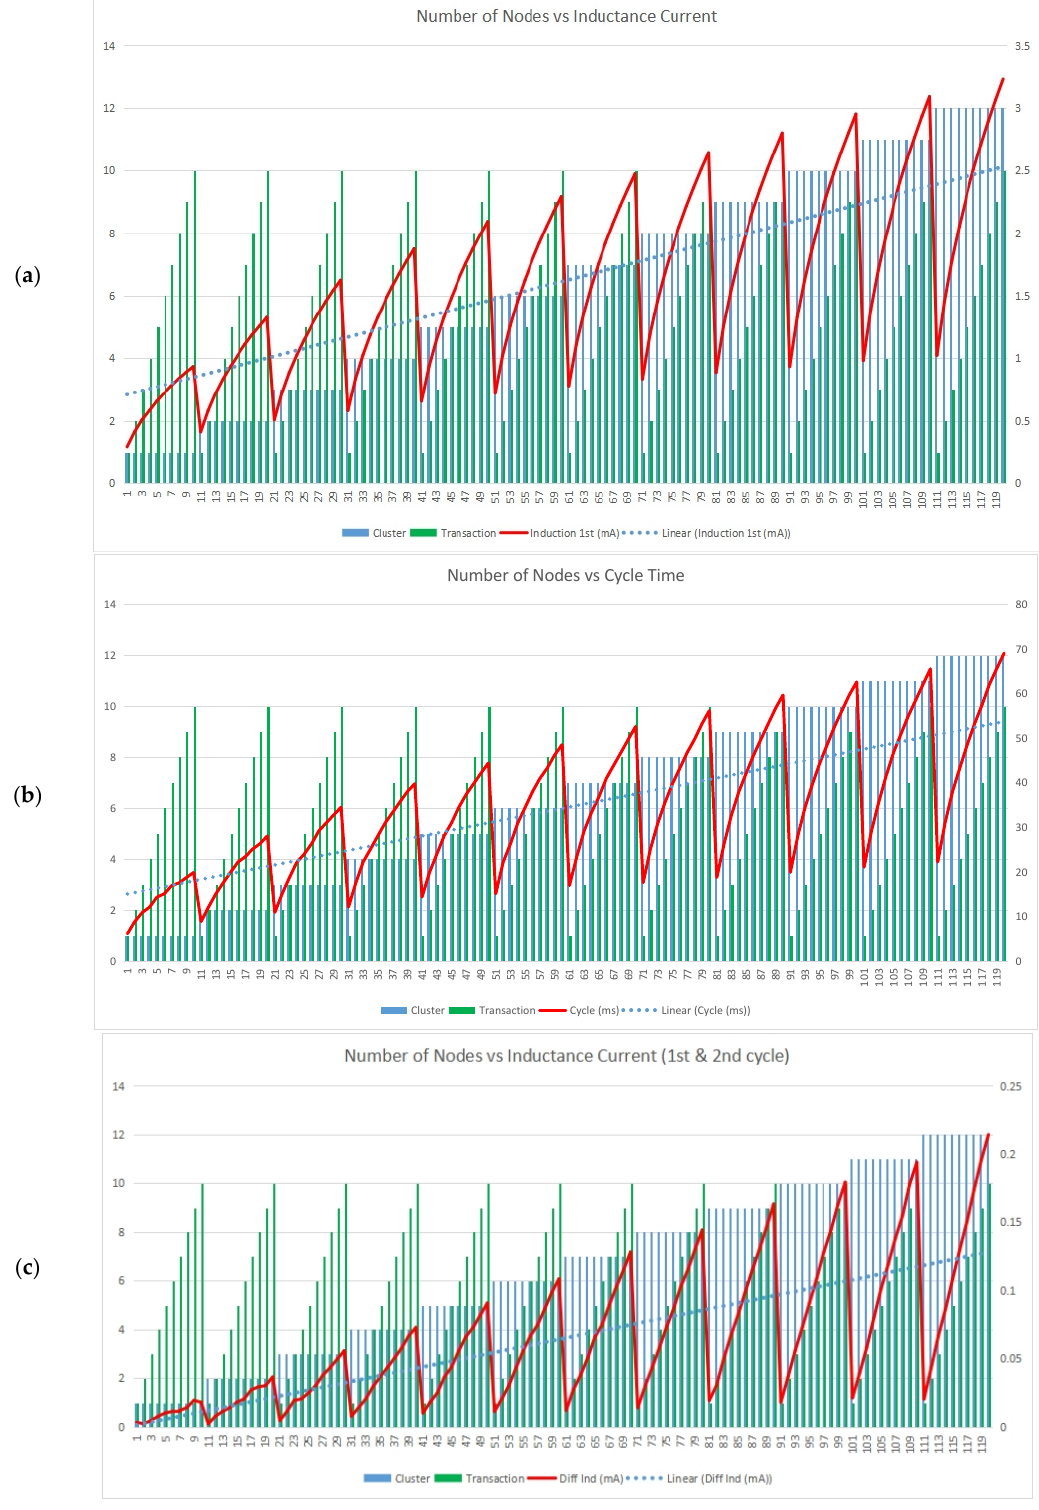
Figure 21. LTSPICE Results ( a ) Number of nodes vs. inductance current clustered chart; ( b ) Number of nodes vs. cycle time clustered chart; ( c ) Number of nodes vs. inductance difference (1st & 2nd cycle) clustered chart.